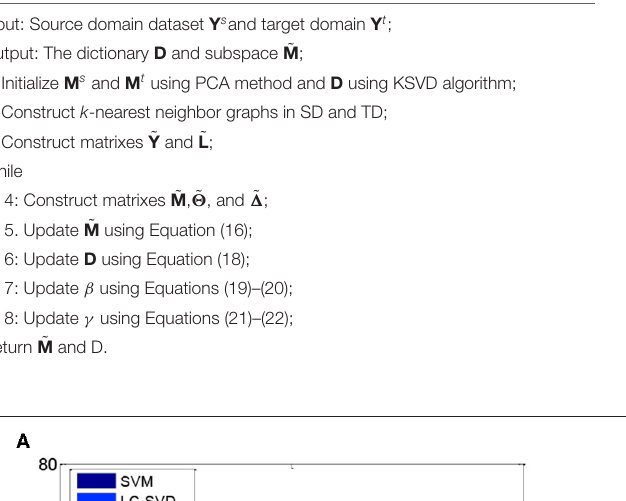
Frontiers in Psychology |